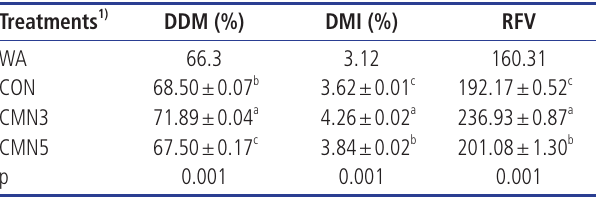
Table 7. Dry matter digestibility, dry matter intake and relative feed value of alfalfa silages Treatments